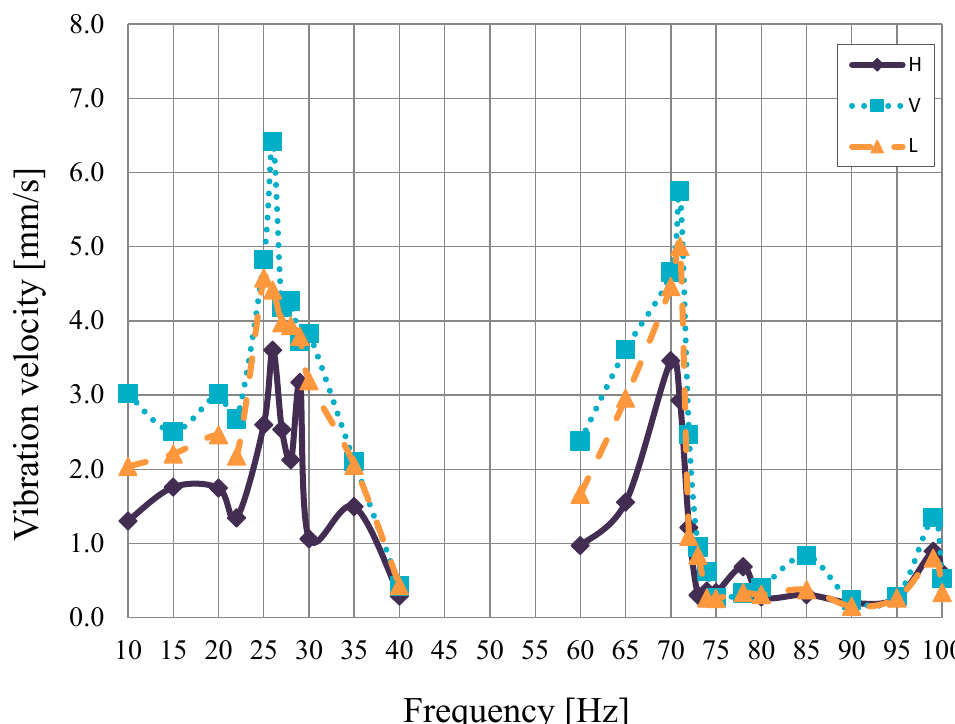
Figure 24. Measured broad-band vibration velocity for Case A in the horizontal (H), vertical (V) and longitudinal (L) directions versus the frequency of voltage subharmonics and interharmonics occurring as a single power quality disturbance.